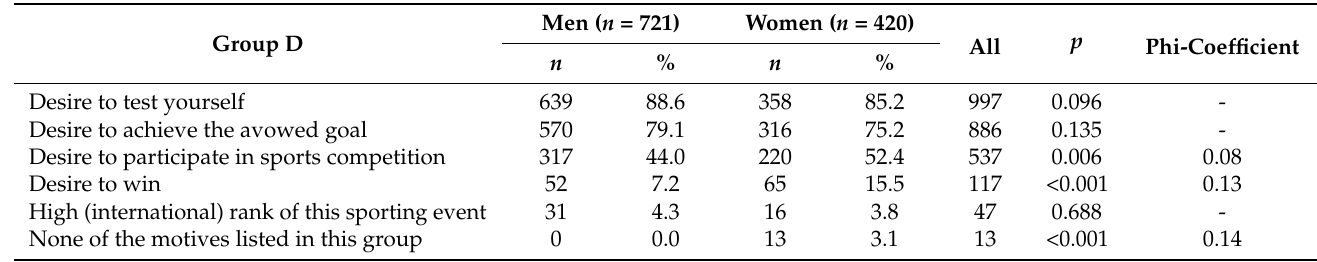
Table 5. Motives within the scope of result